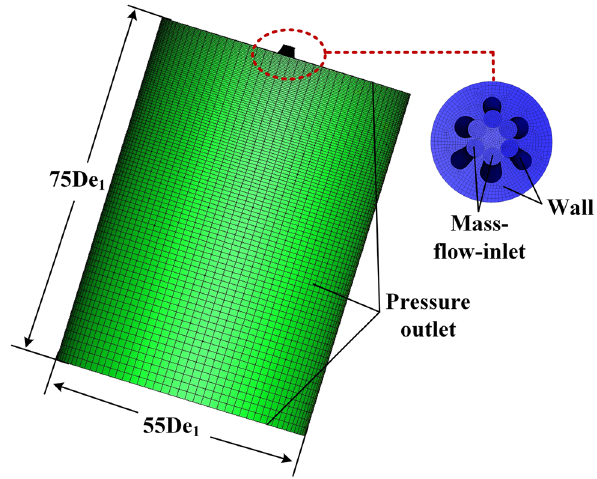
Figure 2: Calculation of the domain structure and the boundary setting of the dual - parameter oxygen lance nozzle.